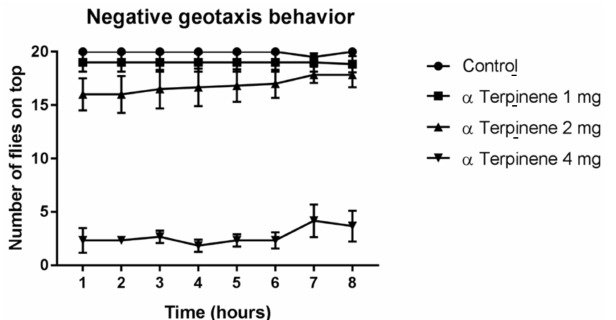
Figure 7. Effect of α -terpinene on D. melanogaster locomotor ability. Subtitles: Locomotor activity was determined by negative geotaxis behavior. Results are expressed as the mean ± SD of the number of flies able to climb a marked glass column, as previously described, at each exposure time.